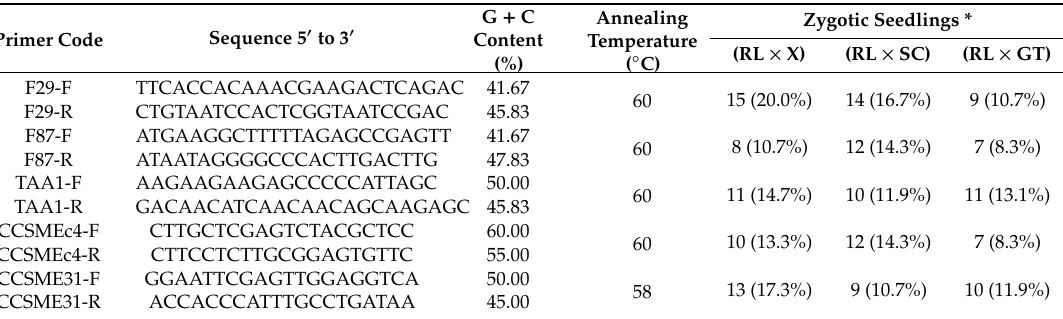
Table 7. Identification of zygotic seedlings with five SSR markers in RL × X (75 seedlings), RL × SC, and RL × GT (84 seedlings) crosses from unifoliate leaf